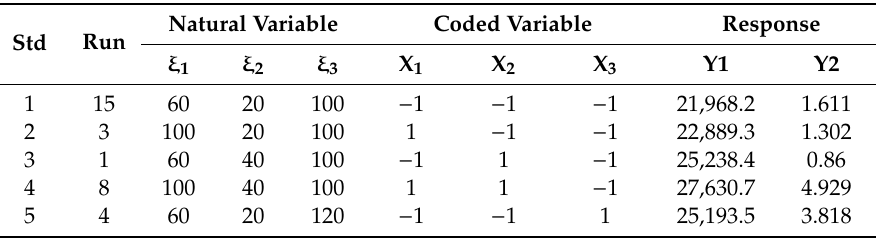
Table 3. Summary of various research responses to the heating value ( Y1 ) and compressive strength ( Y2